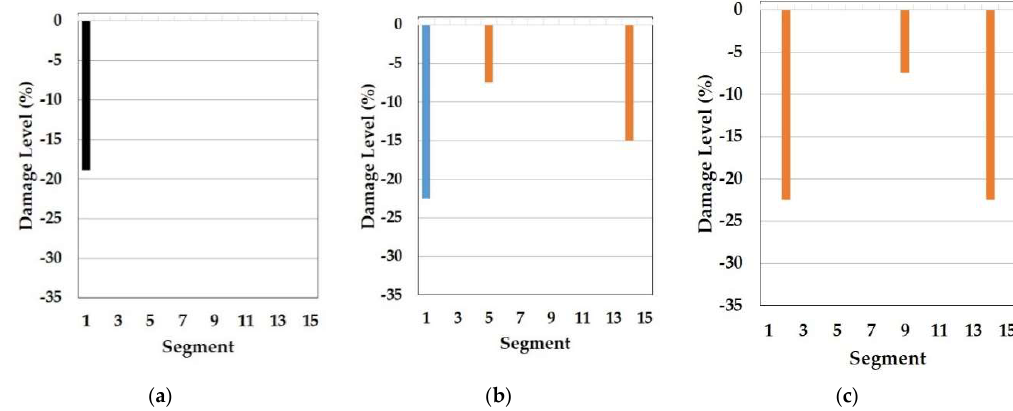
Figure 13. Independent baseline model under DS1 (blue color is correct segment whereas orange color is incorrect segment): ( a ) Predicted damage from the GA (black color); ( b ) top one damage case using the first to fourth natural frequencies; ( c ) top two damage case using the first to fourth natural frequencies